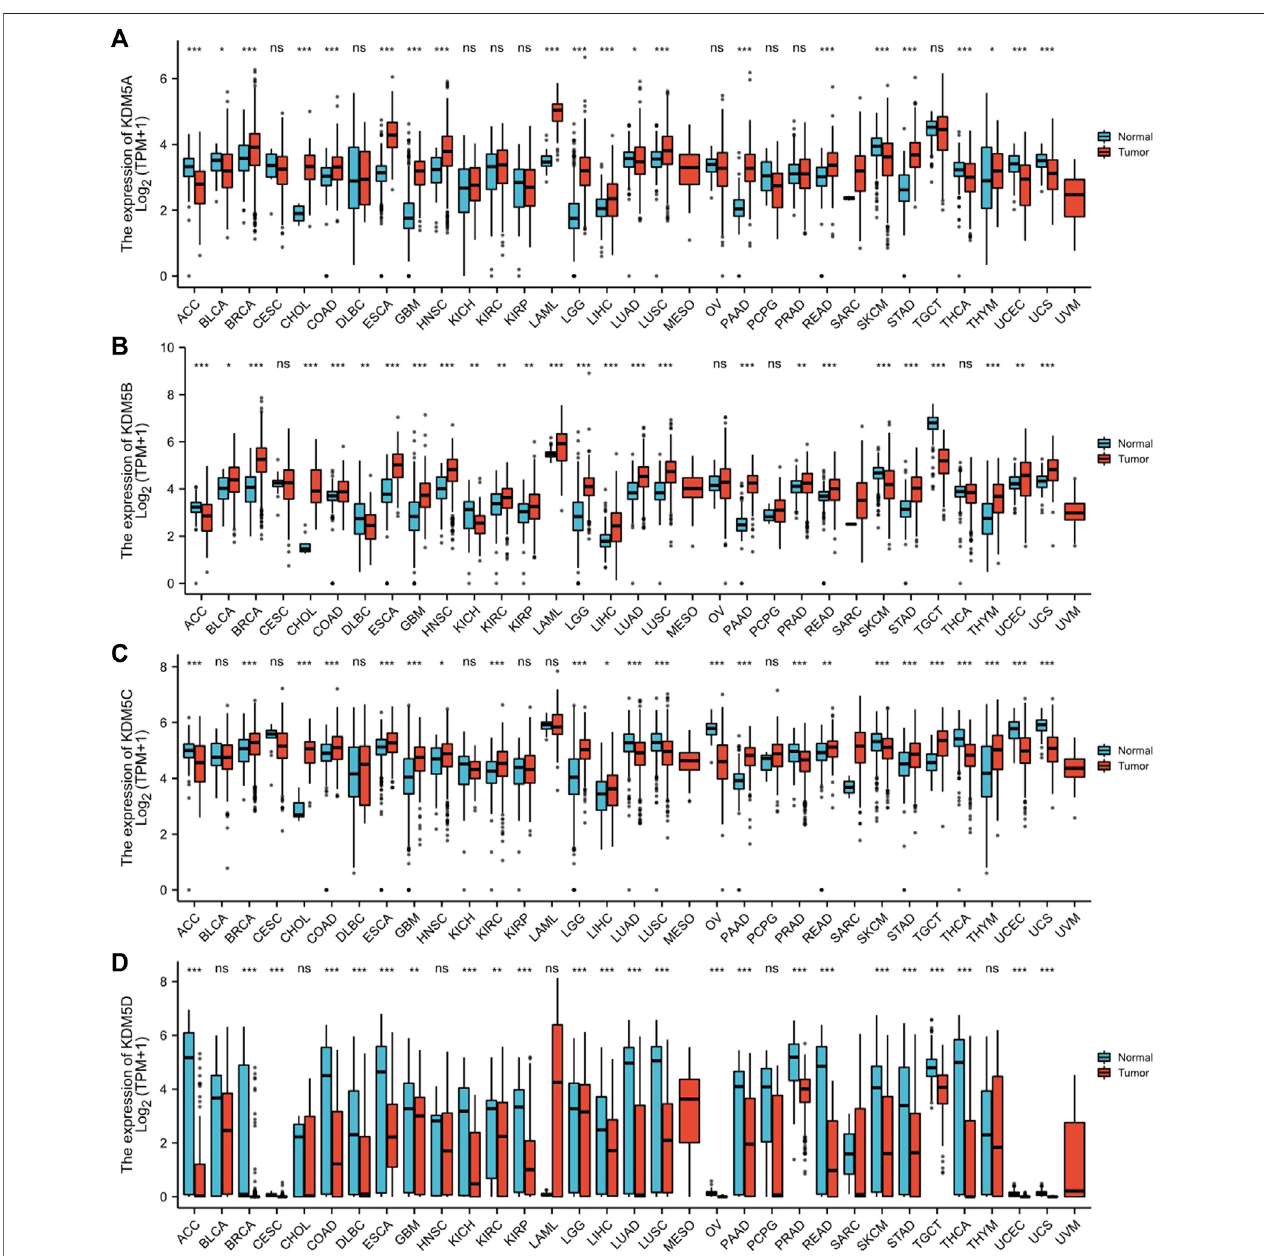
FIGURE 1 | The expression level of the KDM5 family in different tumor tissues and paracancerous tissues in the TCGA database and normal tissues in the GTEx database. (A) TheexpressionlevelofKDM5A; (B) TheexpressionlevelofKDM5B; (C) TheexpressionlevelofKDM5C; (D) TheexpressionlevelofKDM5D.ns, p ≥ 0.05;*, p < 0.05; **, p < 0.01; ***, p < 0.001.